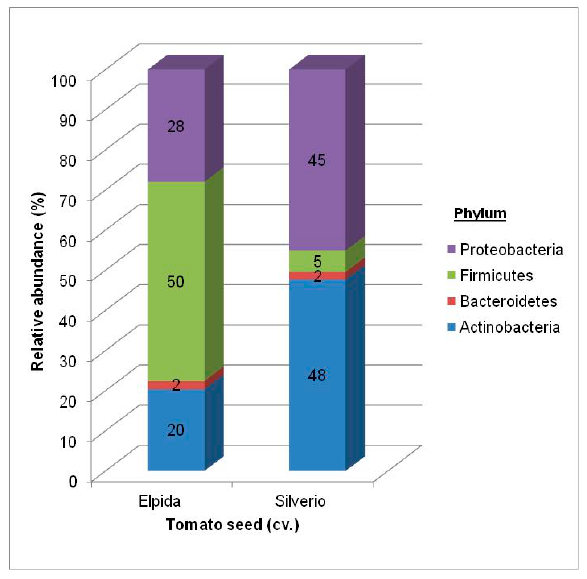
Figure 1. Taxonomic profiles of the bacterial community in each system at the phylum level with the relative abundance (>0.5%).